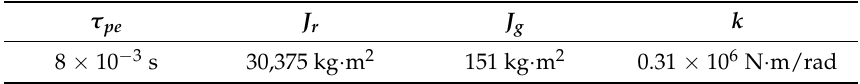
Table 1. Mechatronic parameters of the 100-kW horizontal-axis wind turbine power system.